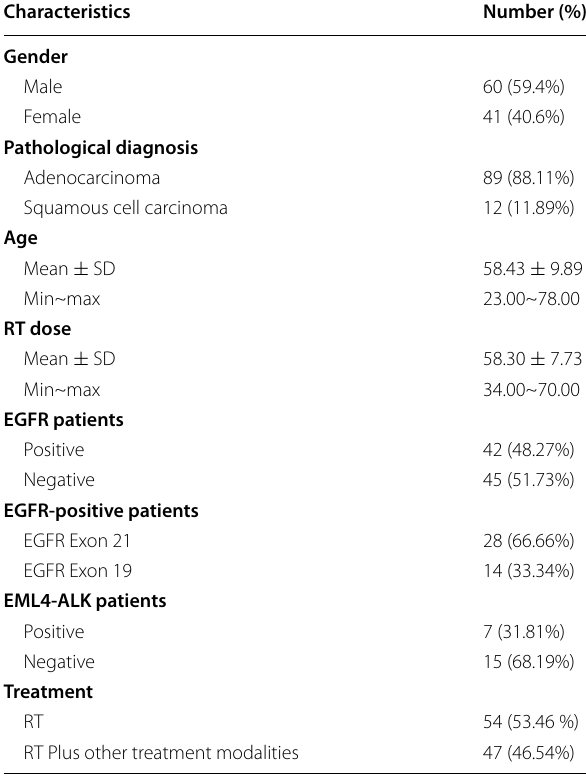
Table 1 Patients characteristics